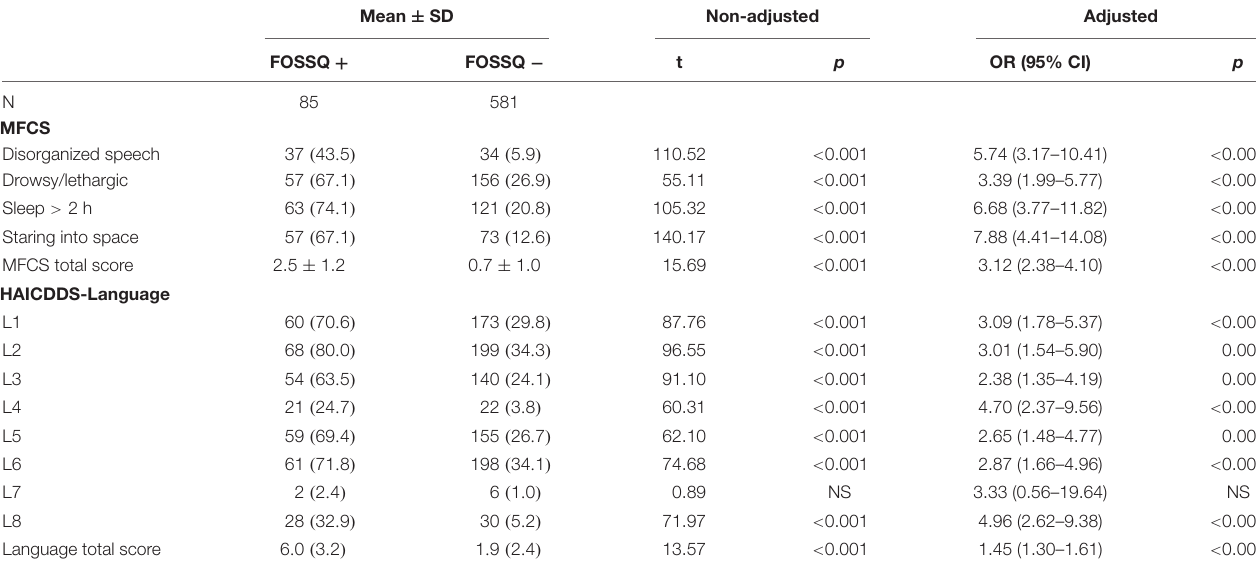
TABLE 4 | Comparison of frequency of fluctuation symptoms in MFCS and language symptoms in HAICDDS-Language between groups with FOSSQ + and FOSSQ – adjusted for age and disease severity according to